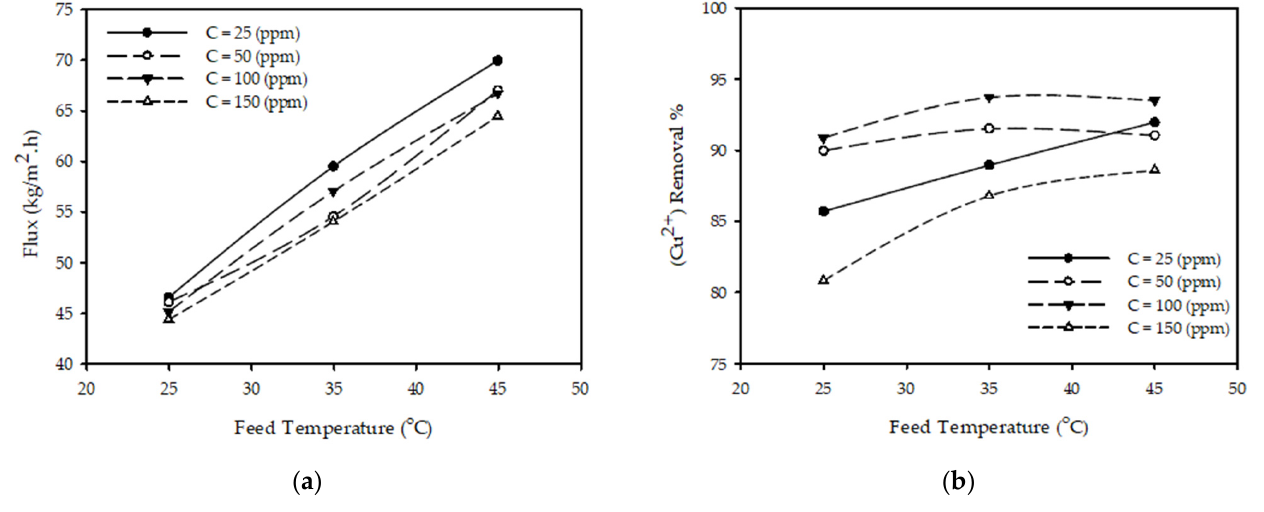
Figure 3. Effect of feed temperature on ( a ) permeate flux ( b ) (Cu 2+ ) removal % at different feed concentrations for constant feed flow rate 3.2 (L/min) and pressure 10 (bar).